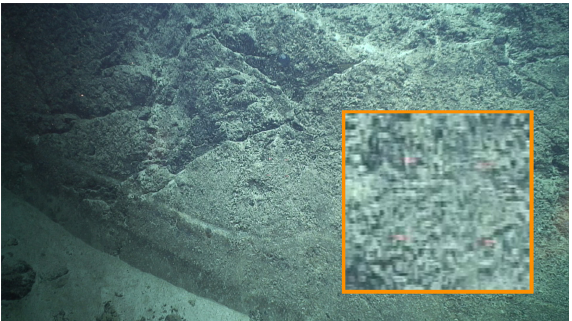
Figure 7. Example of image used for scale error evaluation with enlarged laser